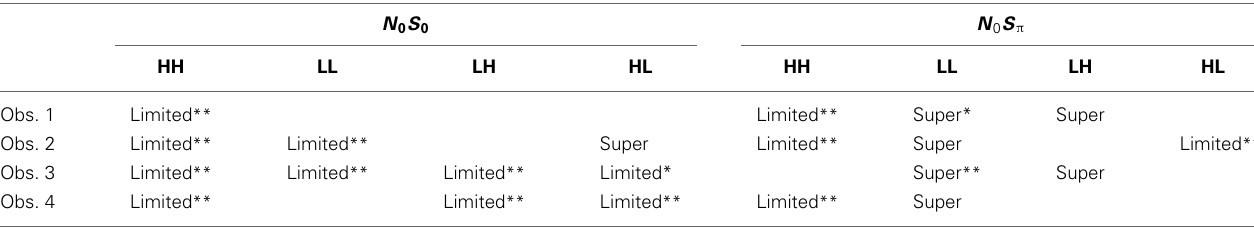
Table 5 | Statistical inferences for the capacity